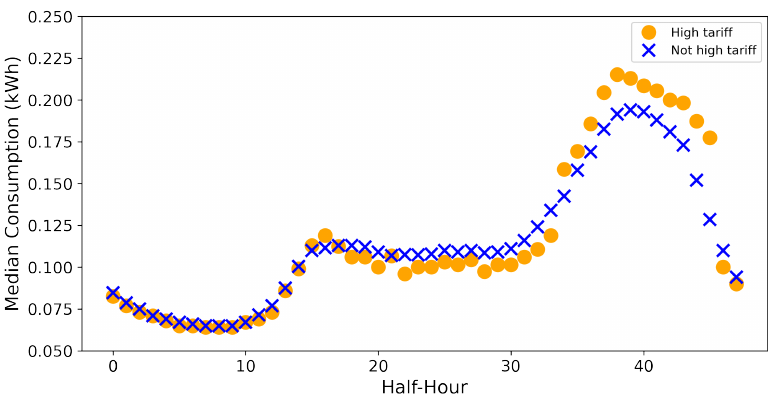
Figure 2. LCL ToU consumer median load profile when tariffs are high and when they are